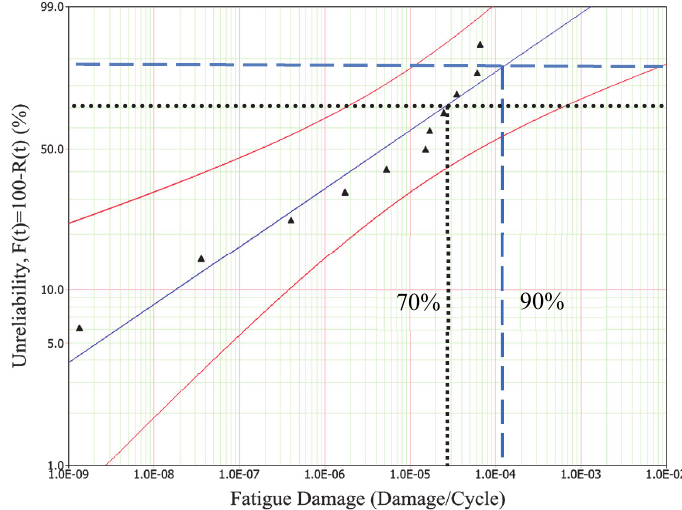
Figure 7: The Weibull probability distribution plots of fatigue damage for S1.